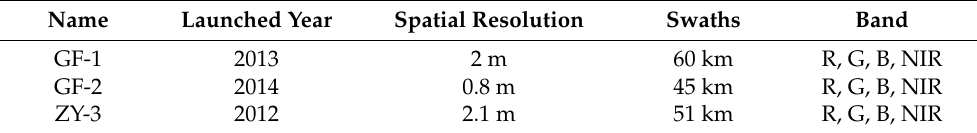
Table 2. The metadata information of remote sensing imagery.